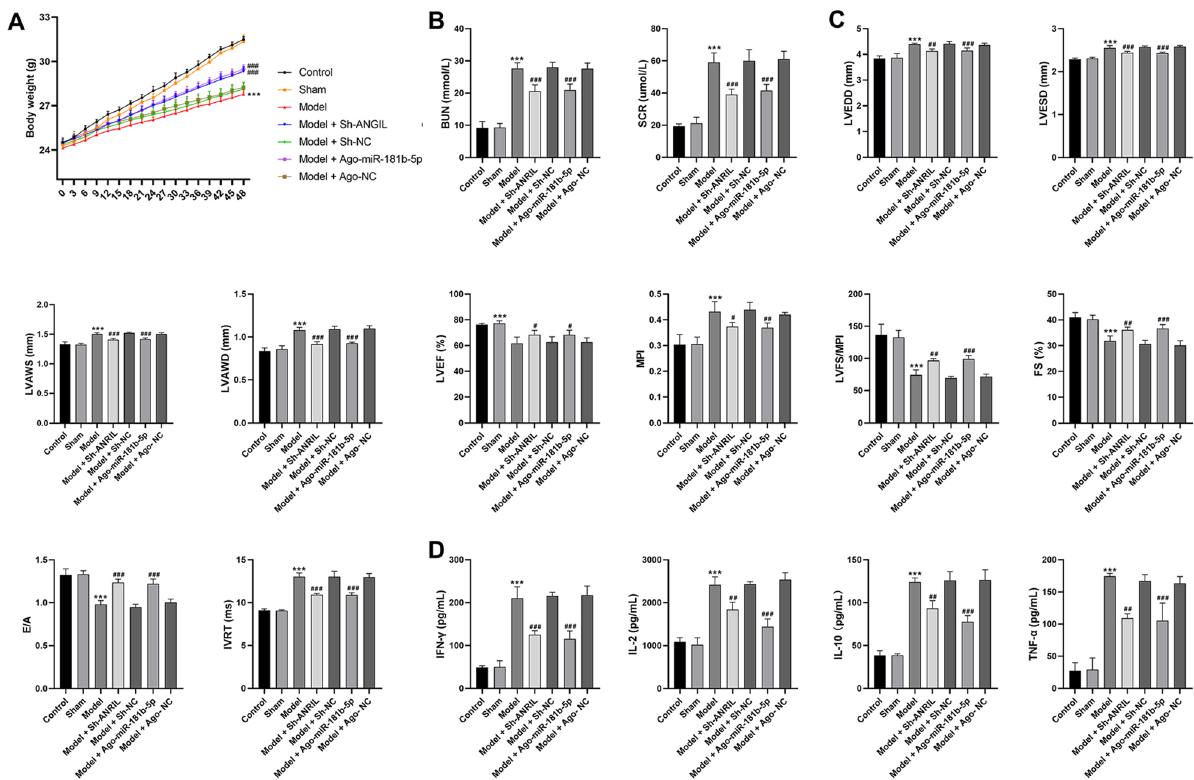
Figure 5. The effects of ANRIL silencing or miR-181b-5p overexpression on the characteristics of UC in the model mice ( A ) body weight; ( B ) serum levels of BUN and Scr; ( C ) cardiac parameters (LVEDD, LVESD, LVAWS, LVAWD, LVEF, MPI, LVEF/MPI, FS, E/A, and IVRT); ( D ) serum levels of inflammatory parameters (IFN-γ, IL-2, IL-10, and TNF-α). ***P < 0.001 vs. control; # P < 0.05, ## P < 0.01, ### P < 0.001 vs. model. Data was analyzed using t test or one-way analysis of variance (ANOVA) followed by Tukey’s ultrasound imaging system (Visualsonic Vevo 2100, Toronto, Canada). After measurements, mice were anesthe- tized and sacrificed by cervical dislocation, and the myocardial and nephridial tissues were resected. Hematoxylin–Eosin (HE) and Masson staining. HE and Masson staining were performed to evaluate the pathological changes and fibrosis, respectively. The collected myocardial and nephridial tissues were fixed in 10% formaldehyde, embedded in paraffin, and sliced into 5 μm sections. After dewaxed in xylene and rehydrated in graded ethanol, the sections were stained using HE kit (Beyotime, Beijing, China) or MASSON kit (Solarbio, Beijing, China) according to the instructions. The stained sections were subsequently dehydrated with graded ethanol, vitrificated with dimethylbenzene, and observed under a microscope (BX53, Olympus, Japan). Immunofluorescence. The paraffin-embedded sections of myocardial tissues were dewaxed in xylene, dehydrated with graded ethanol, and microwave irradiated for 15 min at 95 °C for antigen retrieval. The sec- tions were then blocked with 5% bovine serum albumin (BSA) for 1 h and incubated with anti-S1PR1 (1:100; Invitrogen, Carlsbad, CA, USA, MA5-32587) for 12 h at 4 °C. After three times of washing with phosphate buffer saline (PBS), the sections were incubated with Cy3-conjugated secondary antibody (1:1000, Abcam, Cambridge, MA, USA, ab6939) combined with DAPI (Beyotime) for 1 h under darkness. The stained sections were finally captured under a fluorescence microscope (CKX53, Olympus). T cell detection. Lymphocytes were separated from blood samples by 30 min of centrifugation at 600 g . After washed with PBS, the isolated lymphocytes were blocked in 5% BSA for 30 min, and incubated with anti- CD3 (Invitrogen, #11-0032-82), -CD44 (Invitrogen, #12-0441-82), and -Th17A (Invitrogen, #11–7177-81) for 30 min at 4 °C. T cells were analyzed on a flow cytometer (CytoFLEX S, Beckman, Miami, FL, USA). The raw data were collected and exposed to dot plot analysis by applying CellQuest Pro software package. T cell isolation, activation, and transfection. T cells isolated from blood samples of control mice were cultured in RPMI 1640 Medium supplemented with 10% fetal bovine serum (FBS) and 100 U/mL penicillin/ streptomycin at 37 °C with 5% CO 2 . Anti-CD3 and -CD28 were added to activate T cells. sh-ANRIL/sh-NC and miR-181b-5p mimic (Forward: 5 ′ -AAC AUU CAU UGC UGU CGG UGGGU-3 ′ , reverse 5 ′ -CCA CCG ACA GCA AUG AAU GUUUU-3 ′ )/mimic NC (Forward: 5 ′ -UUC UCC GAA CGU GUC ACG UTT-3 ′ , reverse 5 ′ -ACG